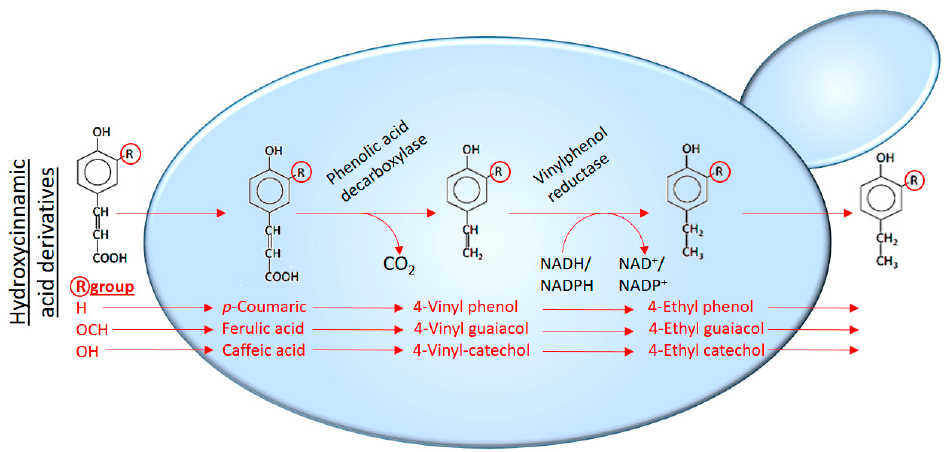
Figure 8. Formation of 4-ethyl derivatives from their correspondent hydroxycinnamic precursors by strains of the Brettanomyces/Dekkera genus.